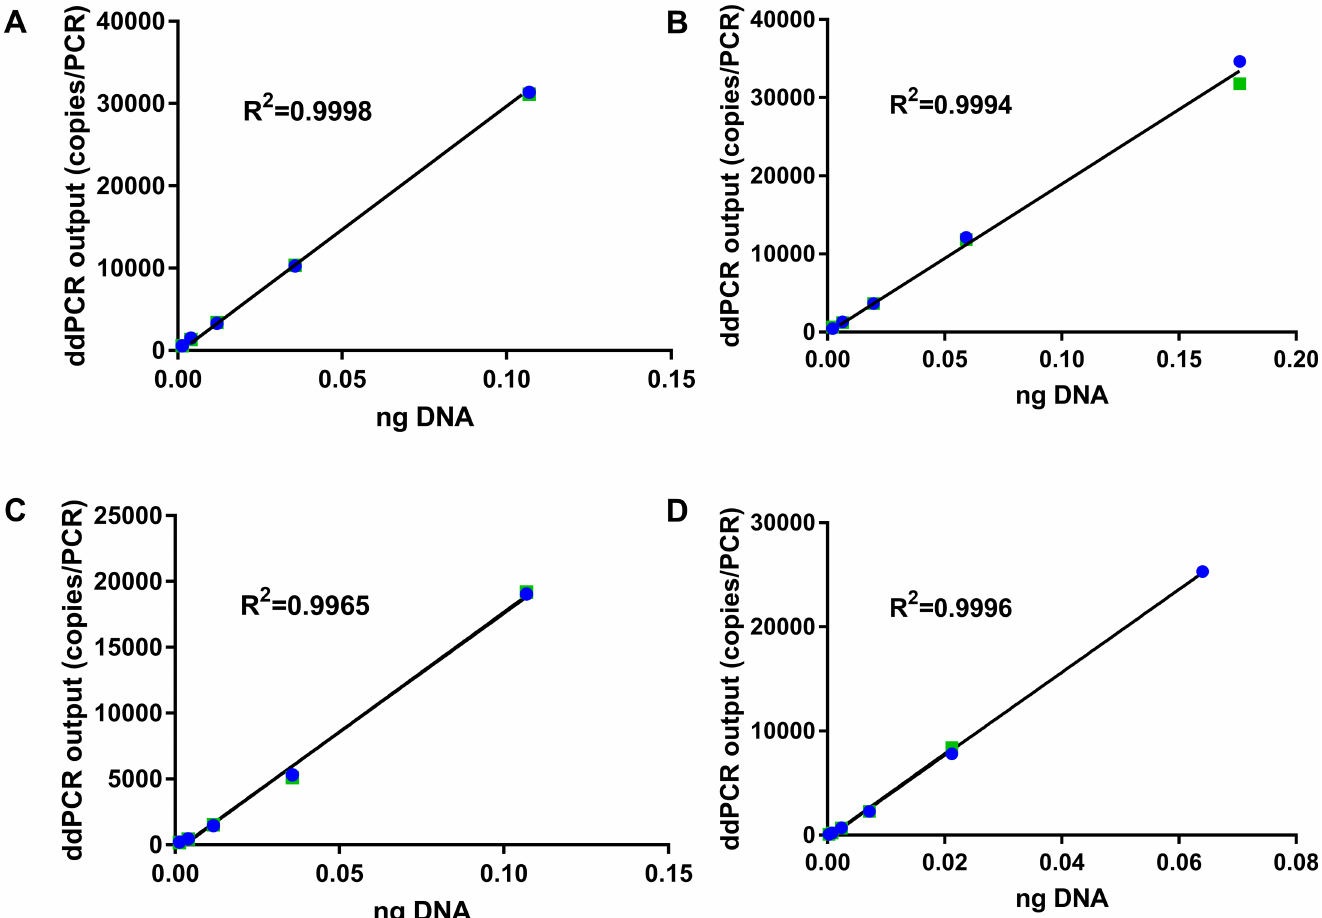
Fig 1. Linear regression between ddPCR output (copies/PCR) and DNA amount (ng). DNA was extracted from fresh raw (A) beef, (B) pork, (C) chicken, and (D) turkey. Shown are results from two replicates in green and blue colors.